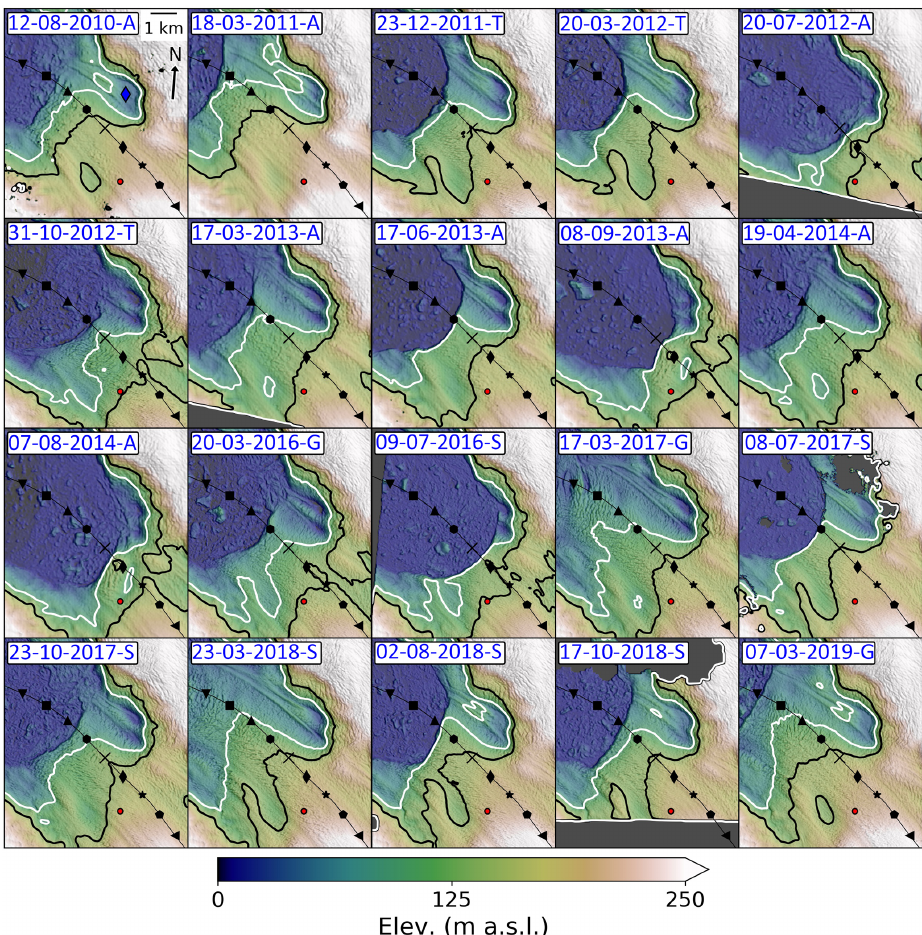
Figure 4. Colour-shaded relief maps for of a subset of DEMs, excluding maps for 2015, which are included in Fig. 8. Elevation contours of 150 (black) and 100m (white) bound the approximate transition from grounded to floating ice. The elevation data were lightly smoothed prior to contouring to eliminate crevasse noise. The letter after the date-string (DD-MM-YYYY) indicates the DEMs source (A: ASP WorldView; T: TanDEM-X; S: SETSM WorldView; and G: GLISTIN). The profile with symbols every 1km is the same as shown in Fig. 1, and the red dot shows the location of M6. The blue diamond in the 12 August 2010 panel is referenced in the